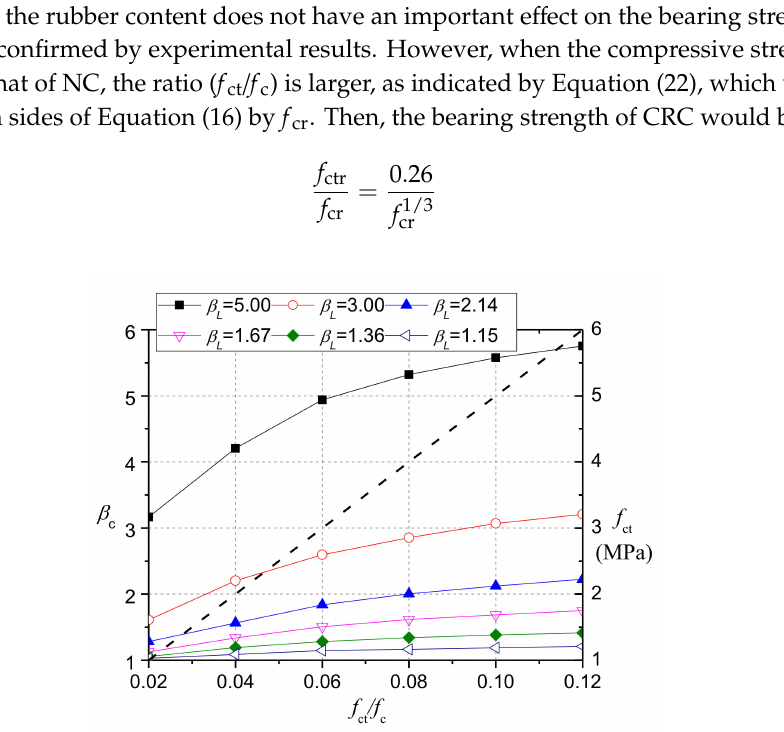
Figure 24. E ff ect of the ratio ( f ct / f c ) on the value of β c